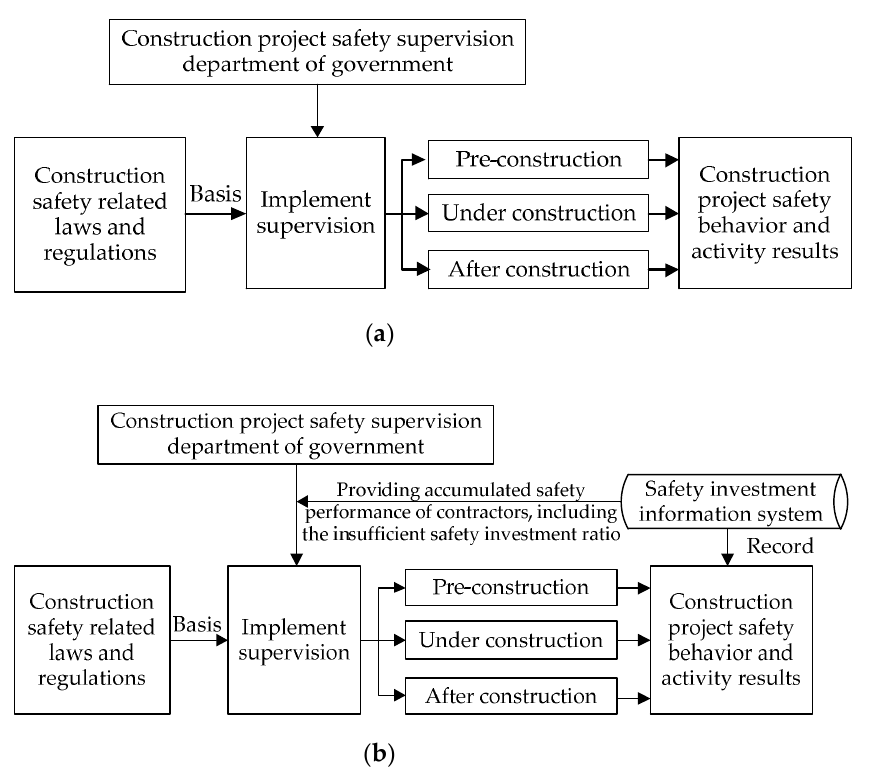
Figure 4. Structural diagram of supervision mechanism: ( a ) static supervision and ( b ) dynamic supervision.